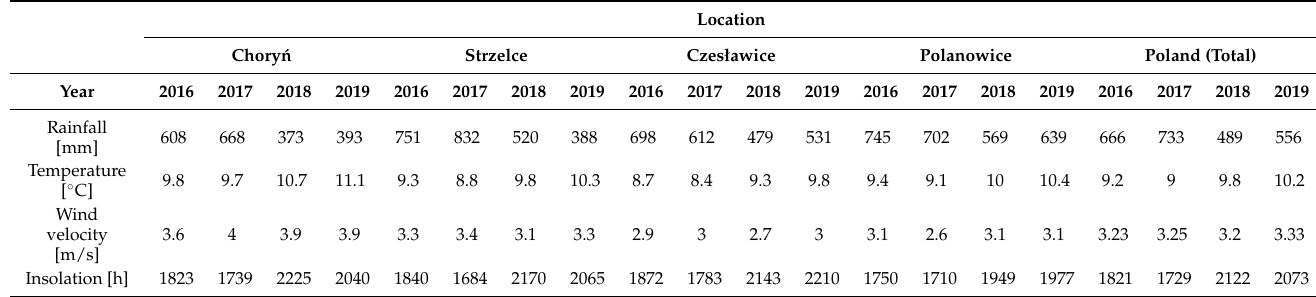
Table 6. Meteorological data from the years and places of collection of the pathogen population [35].